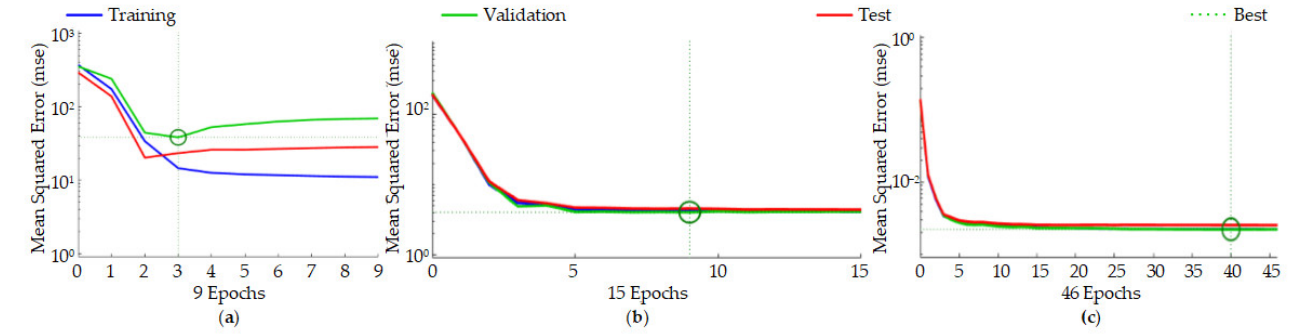
Figure 8. Training results: ( a ) BP model; ( b ) SOM-RBF model; ( c ) RLSOM-RBF model.